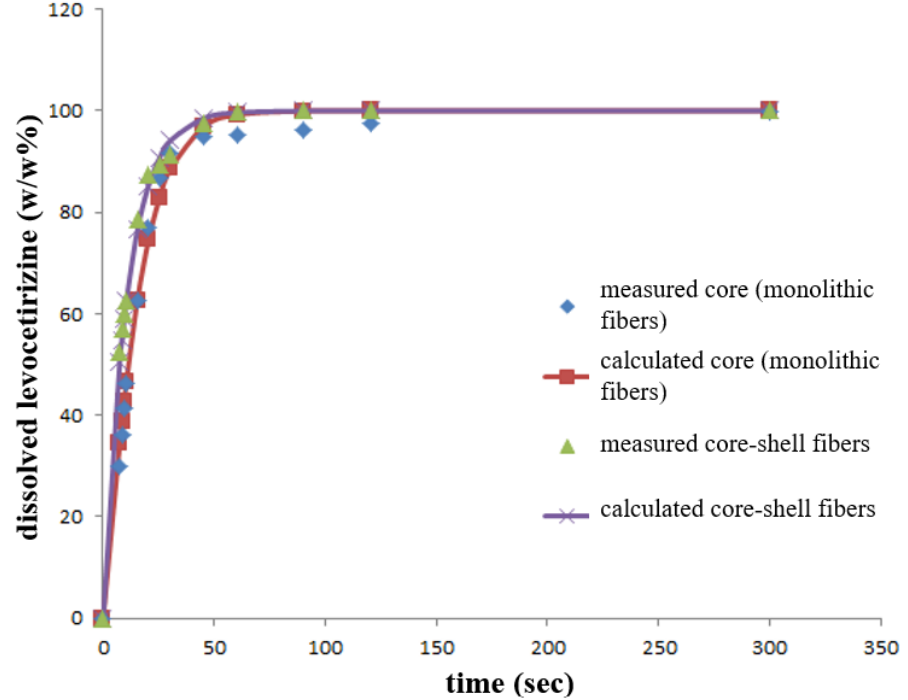
Figure 6. Dissolution profile of levocetirizine-containing monolithic fibers prepared by electrospinning, the coaxially electrospun core–shell fibers (these are the measured curves), and the corresponding calculated curves based on the Weibull model. Table 3. Dissolution kinetic parameters of levocetirizine-containing monolithic fibers prepared by electrospinning and the coaxially electrospun core–shell